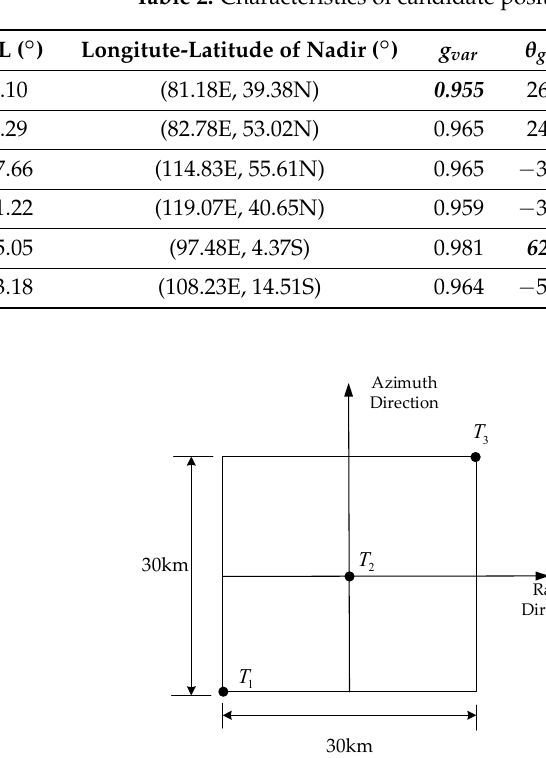
Figure 14. The spatial variance index and ground squint angle curves when observing Wenchuan in full orbit. ( a ) The spatial variance index g var ; ( b ) the ground squint angle θ g . The black dashed line is the Doppler centroid frequency, which has three intersection points with the ground squint angle curve at θ g = 0. These three points are highlighted by green circles, corresponding to the broadside mode in Figure 13a. Table 2. Characteristics of candidate positions.